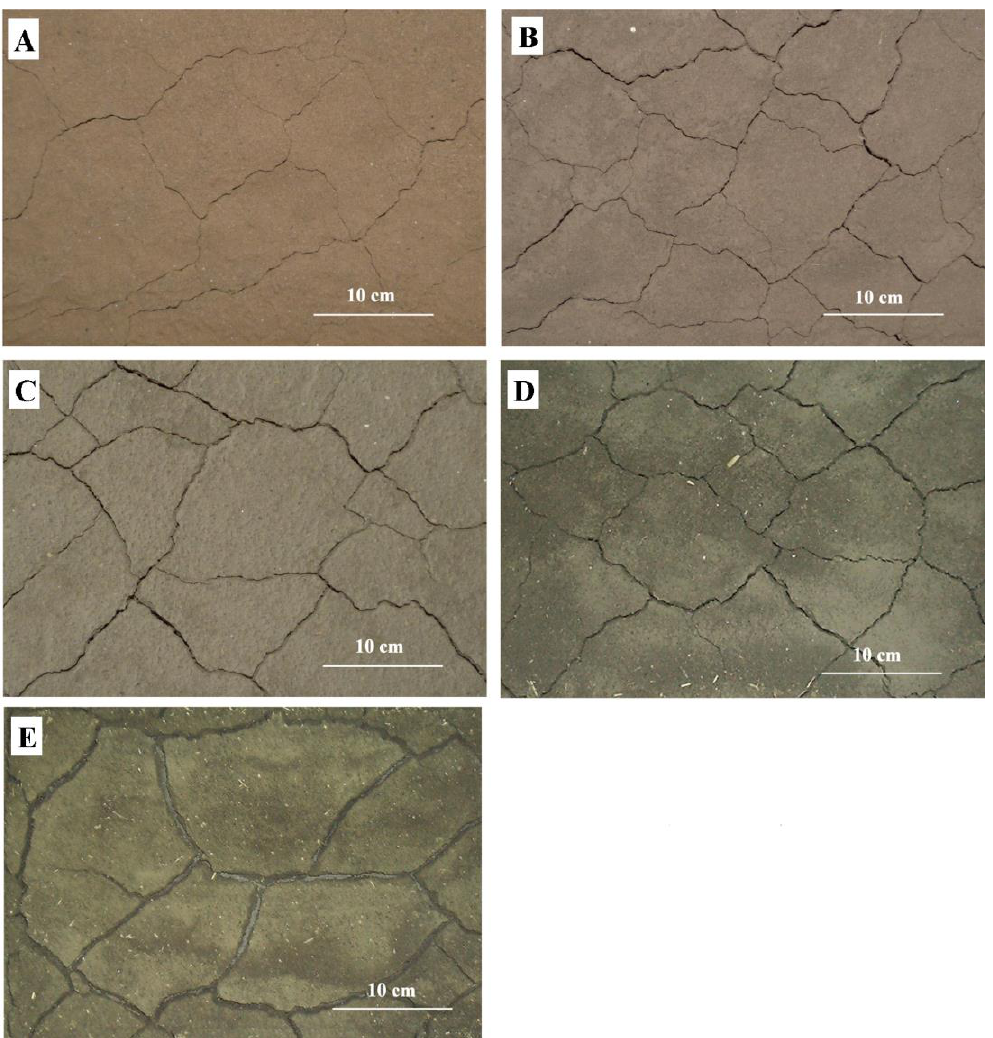
Figure 5. Crusts of various shapes, formed on the surface of soils with different textures after the wind tunnel measurement (( A ): sand, ( B ): loamy sand, ( C ): sandy loam, ( D ): loam, and ( E ): silty loam).